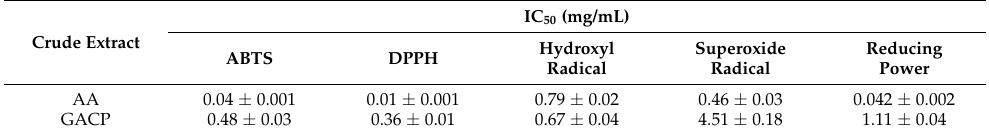
Table 3. IC 50 values of AA and GACP on antiradical activities.